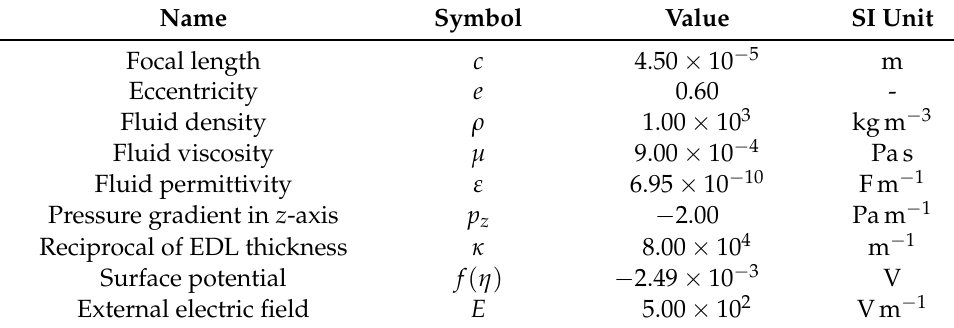
Table 1. Table of parameters used in the transient flow investigation.